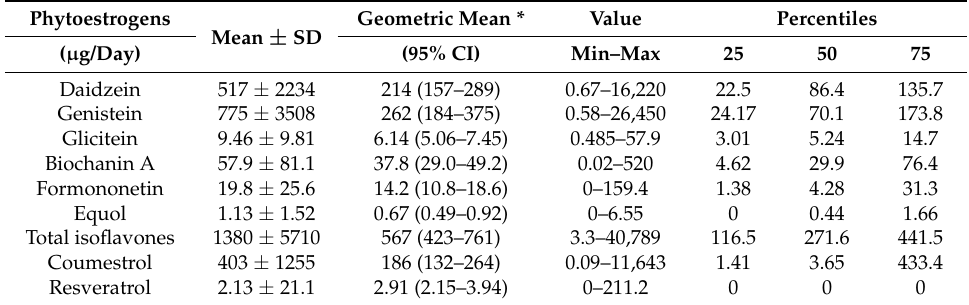
Table 3. Isoflavone, coumestrol, and resveratrol intakes estimated by the 24 h recall in Mexican women ( n = 100).